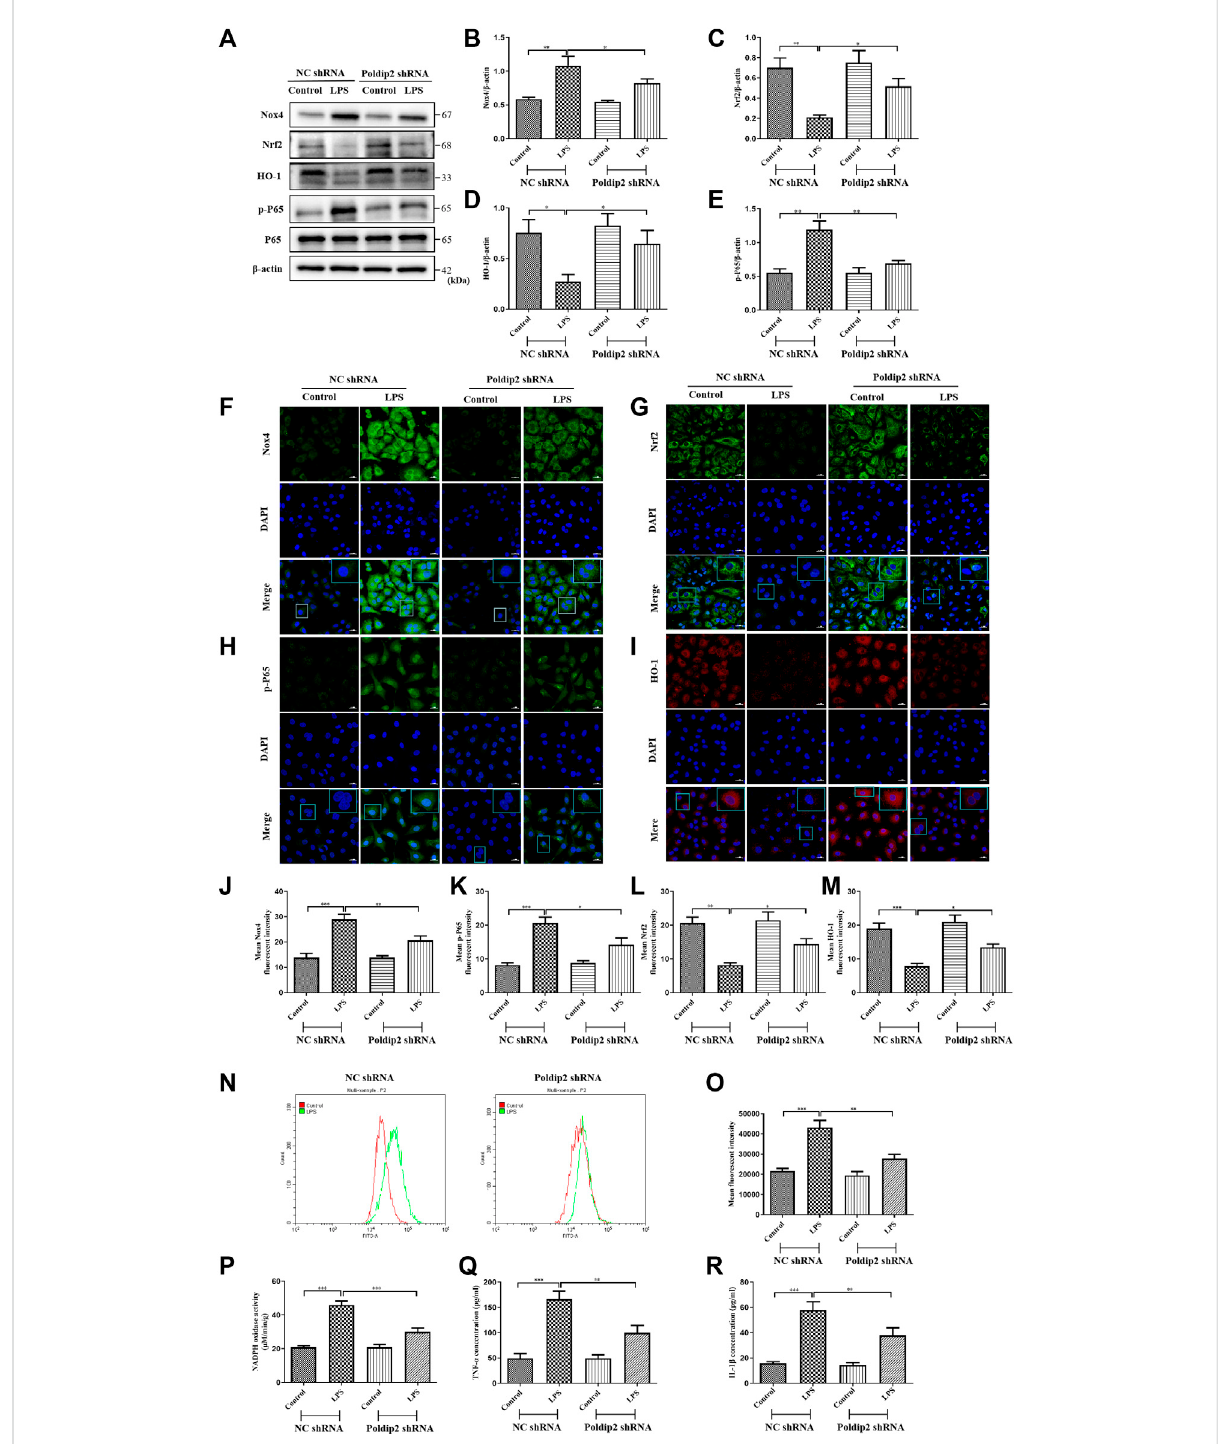
FIGURE 4 Poldip2 knockdown inhibits LPS-induced oxidative stress and the resulting in fl ammation in A549 cells. Con fl uent A549 cells were transfected with lentivirus vector expressing NC shRNA or Poldip2 shRNA for 72 h, and treated with PBS or 10 μ g/ml LPS for 12 h. (A – E) The protein levels of Nox4, Nrf2, HO-1, p-P65 and P65 were detected by western blot (A) and quantitatively analyzed (B – E) . (F – M) Representative images showing immuno fl uorescencestaningofNox4,p-P65,Nrf2andHO-1.CellswerestainedwithNox4,p-P65orNrf2(green)andHO-1(red),andcounter- stained with DAPI (blue) (magni fi cation of ×400), Scale bars are 20 µm. (N,O) The generation of intracellular ROS were detected by fl ow cytometry. (P) The NADPH oxidase activity in A549 cells was detected by spectrophotometer. (Q,R) The levels of TNF- α and IL-1 β in the supernatant were detected by ELISA. Results are represented as mean±SEM of 3 independent experiments. Statistically signi fi cant differences are indicated as ***p < 0.001, **p < 0.01, *p <